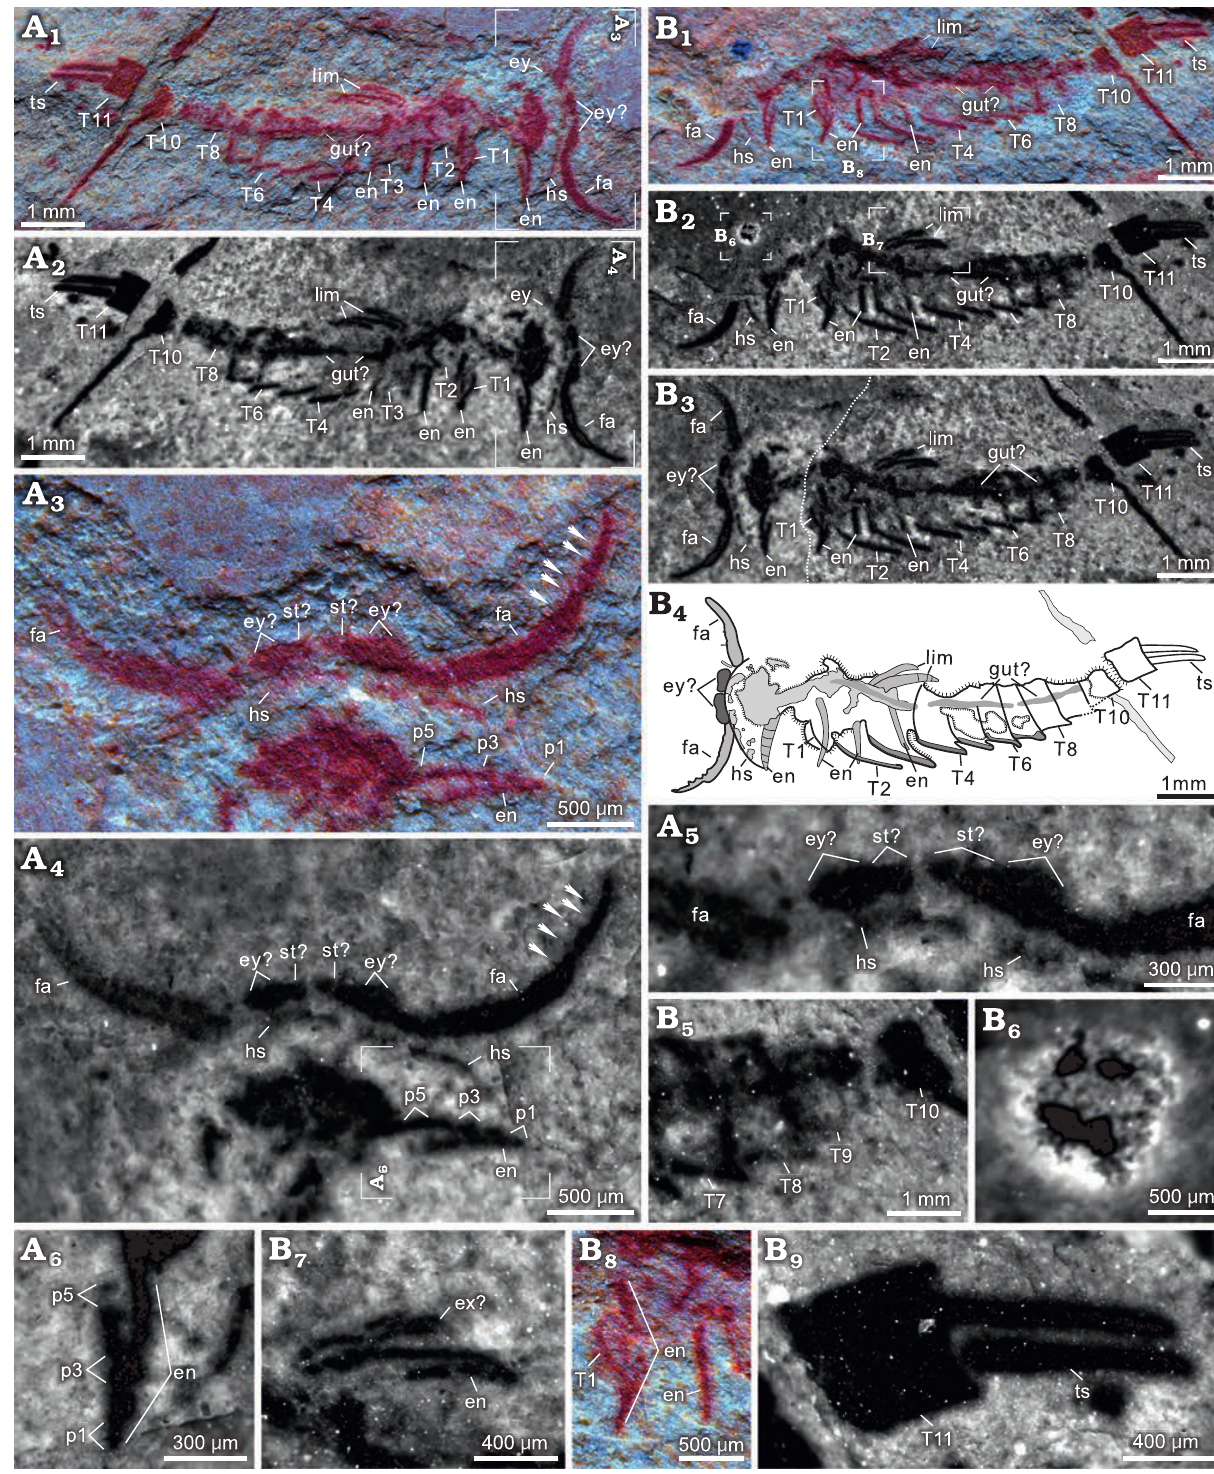
Fig. 1. Euarthropod Astutuscaris bispinifer gen. et sp. nov. from the Cambrian Stage 4 Guanshan Biota, Lihuazhuang village, Yunnan, China. A . RCP 0002a, part of the sole specimen; showing the head shield, 11 imbricated tergites most with pleural spines, and two terminal spines (A 1 , A 2 ); possible eyes (A 3 , A 4 , A 5 ); first appendages with small spines (A 3 , A 4 , white arrows); endopod with at least five podomeres (A 6 ). B . RCP 0002b, counterpart of the sole specimen; note the 11 imbricated tergites and trunk limbs (B 1 , B 2 ); restored specimenby digitally combining the part and counterpart, the dashed line indicating the con- tact (B 3 ); interpretive drawing of the narrow doublures of thoracic tergites marked in dark grey (B 4 ); T7–T10 and pleural spines (B 5 ); detail of the unknown structure (B 6 ); the limb with an endopod and a possible exopod (B 7 ); single endopod under T1 and T2 respectively (B 8 ); T11 and two separate spines being marked (B 9 ). Natural light photographs (A 1 , A 3 , A 4 , B 1 , B 8 ); fluorescent photographs (A 2 , A 5 –A 6 , B 2 , B 3 , B 5 –B 7 , B 9 ). Abbreviations: en, endopod; ex, exo- pod; ey, eye; fa, frontal appendage; gut, digestive tract; hs, head shield; lim, limb; p1–p5, podomeres 1–5; st, stalk; T1–T11, tergites 1–11; ts, terminal